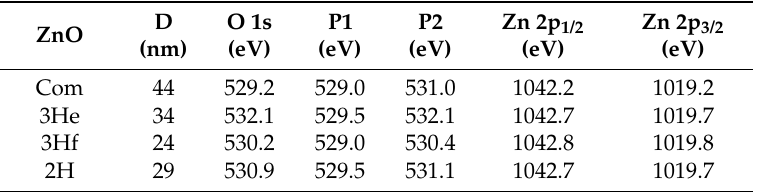
Table 1. The crystalline size (D) calculated from Equation (11); X-ray photoelectron spectroscopy (XPS) chemical shifts of O 1s and Zn 2p signals for commercial ZnO and synthesized by the bipolar electrochemical method. P1 and P2 correspond to resolved peaks of O 2 − ions in the normal and oxygen-deficient lattice,